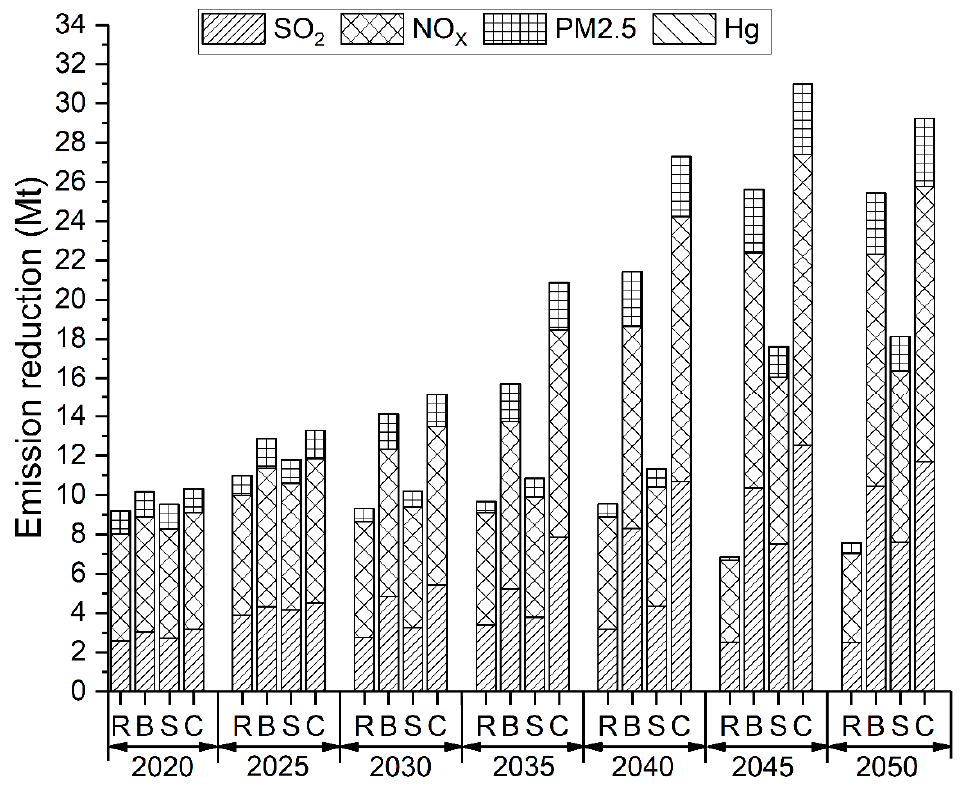
Figure 6. Emission reduction of air pollutants in the power industry.